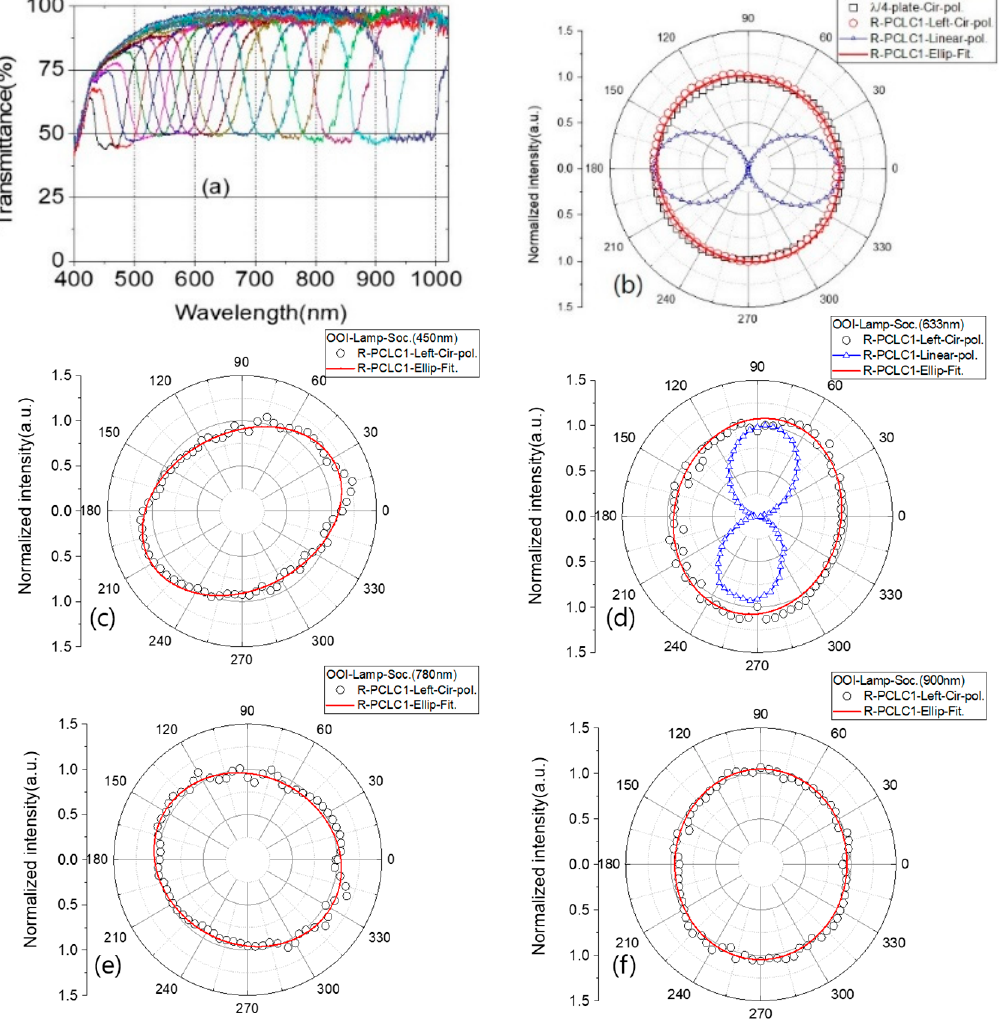
Figure 5. ( a ) Continuous PBG transmission spectra of the R-PCLC1 cell are made by moving it laterally for vertically incident beams. ( b ) Polar plot by using HeNe laser (632.8 nm); ( (cid:3) ), a left-circularly polarized light made by a linear polarizer and a λ plate of 632.8 nm; (o), a left-circularly polarized light passed through the R-PCLC1 cell with a PBG center wavelength at 633 nm; (-) a fitting curve by an elliptic equation; ( (cid:52) ), a linearly polarized light intensity that is converted from the data (o) by a λ plate (632.8 nm). Polar plots by using the halogen and deuterium lamp; the lights passed through the R-PCLC1 cell with a PBG center wavelength at 450 nm ( c ), 633 nm ( d ), 780 nm ( e ), and 900 nm ( f ), respectively. The solid red lines are fitting curves by an elliptic equation. The data ( (cid:52) ) in ( d ) are a linearly polarized light intensity that is converted from the data (o) of ( d ) by a λ plate (632.8 nm). Table 1. The length of semi-major axis a, the length of semi-minor axis b, and the ellipticity (b/a) were obtained by fitting the circularly polarized light data in Figure 5 to the elliptic equation. Light Source ( 𝝀 )